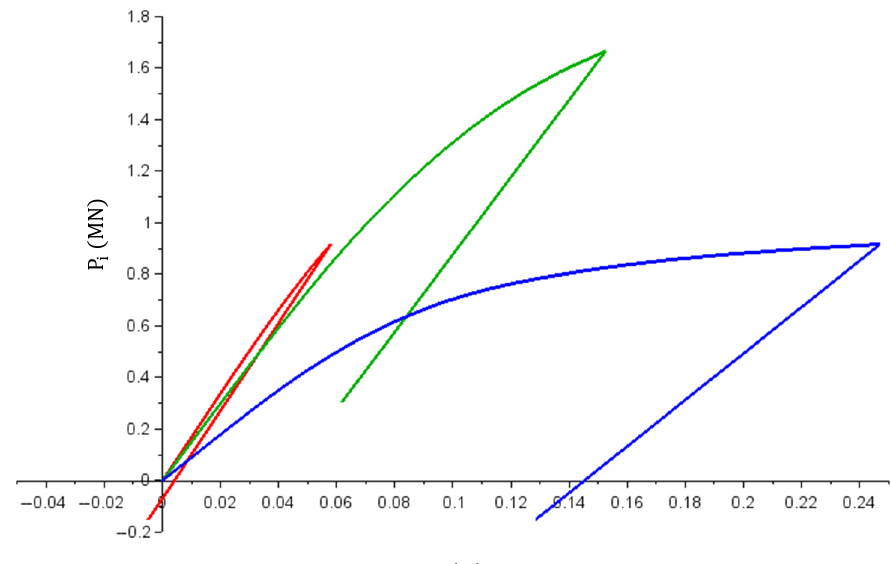
Figure 15 . P (cid:2919) (u (cid:2919) ) graph (i = 1—red; i = 2—green; i = 3—blue).